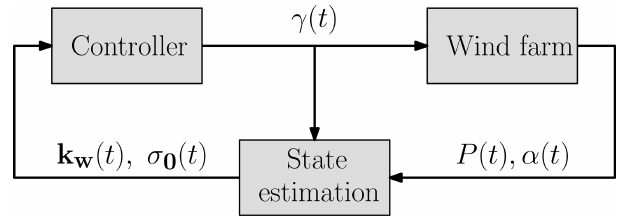
Figure 1. Diagram of the dynamic wake steering control system. The wake model parameters as a function of time are k w ( t ) and σ 0 ( t ), and the yaw misalignment angles are given by γ ( t ). The power production and wind direction are given by P ( t ) and α ( t ), respectively. In open-loop control, the model parameters k w and σ 0 are fixed as a function of